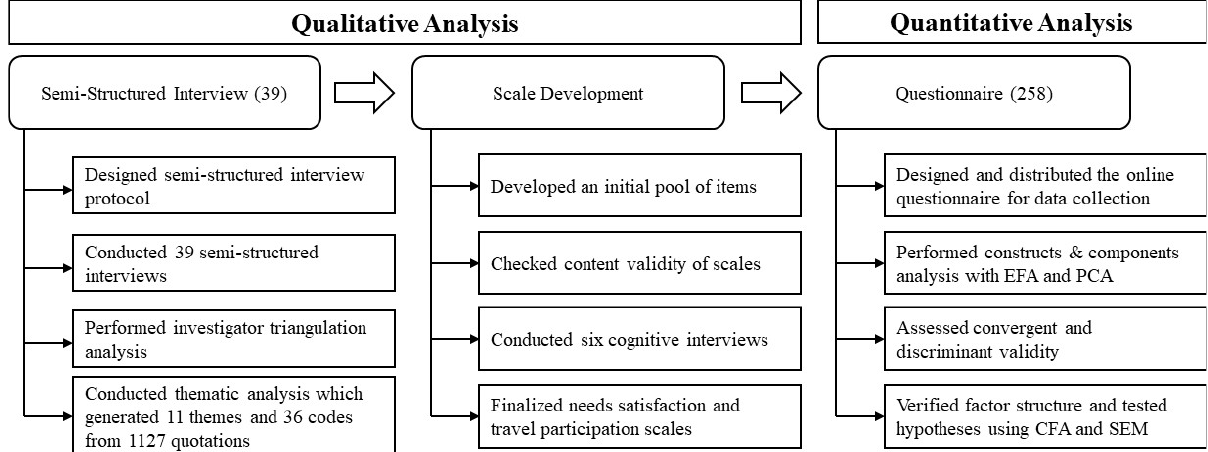
Figure 1. Flow diagram of methodology process.